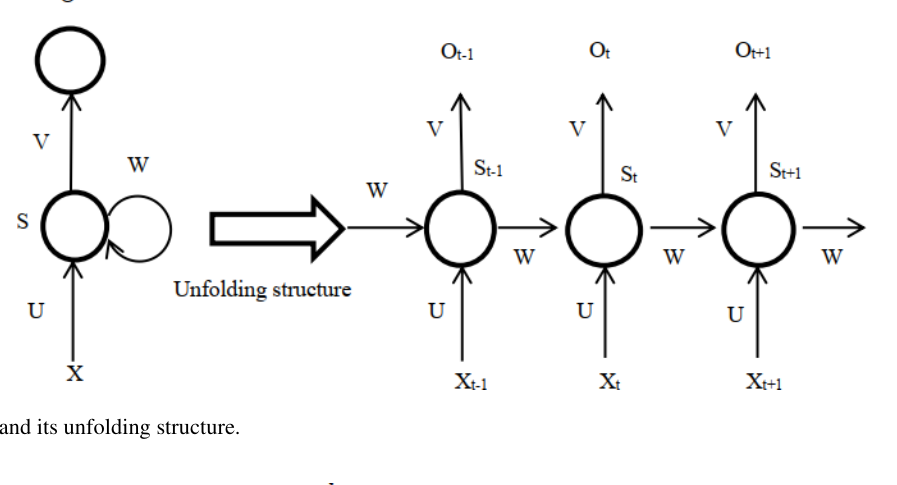
Figure 3. The RNN and its unfolding structure.